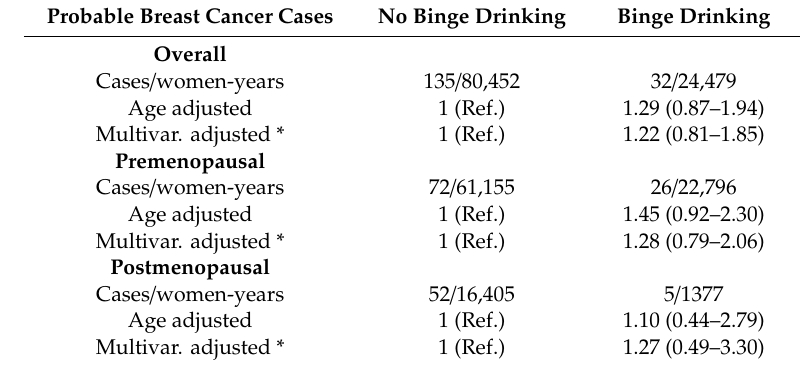
Table 3. Hazard ratio (95% CI) of overall breast cancer—probable cases—and by menopausal status according to binge drinking habit.